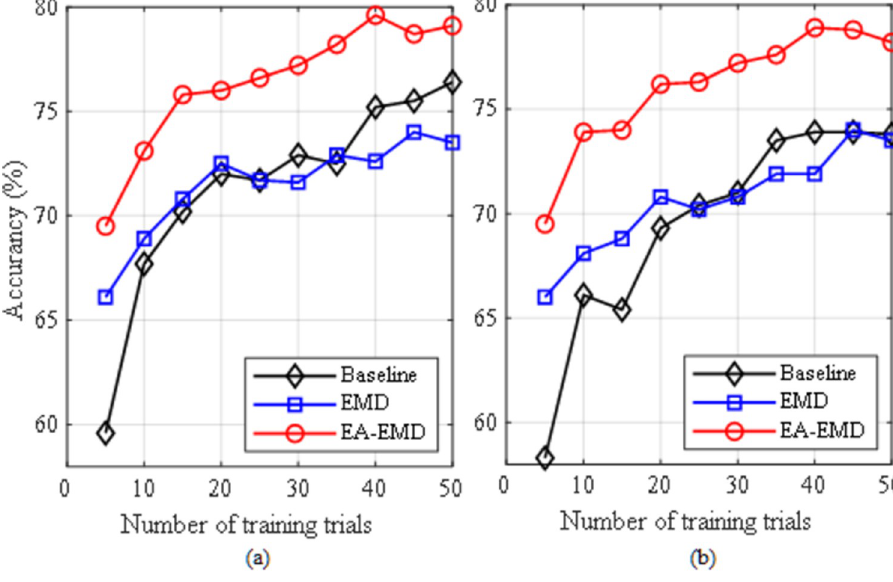
Fig 5. Averaged accuracies across all subjects in dataset 1 yielded by the three classification pipelines using (a) LDA and (b) LR as classifier.